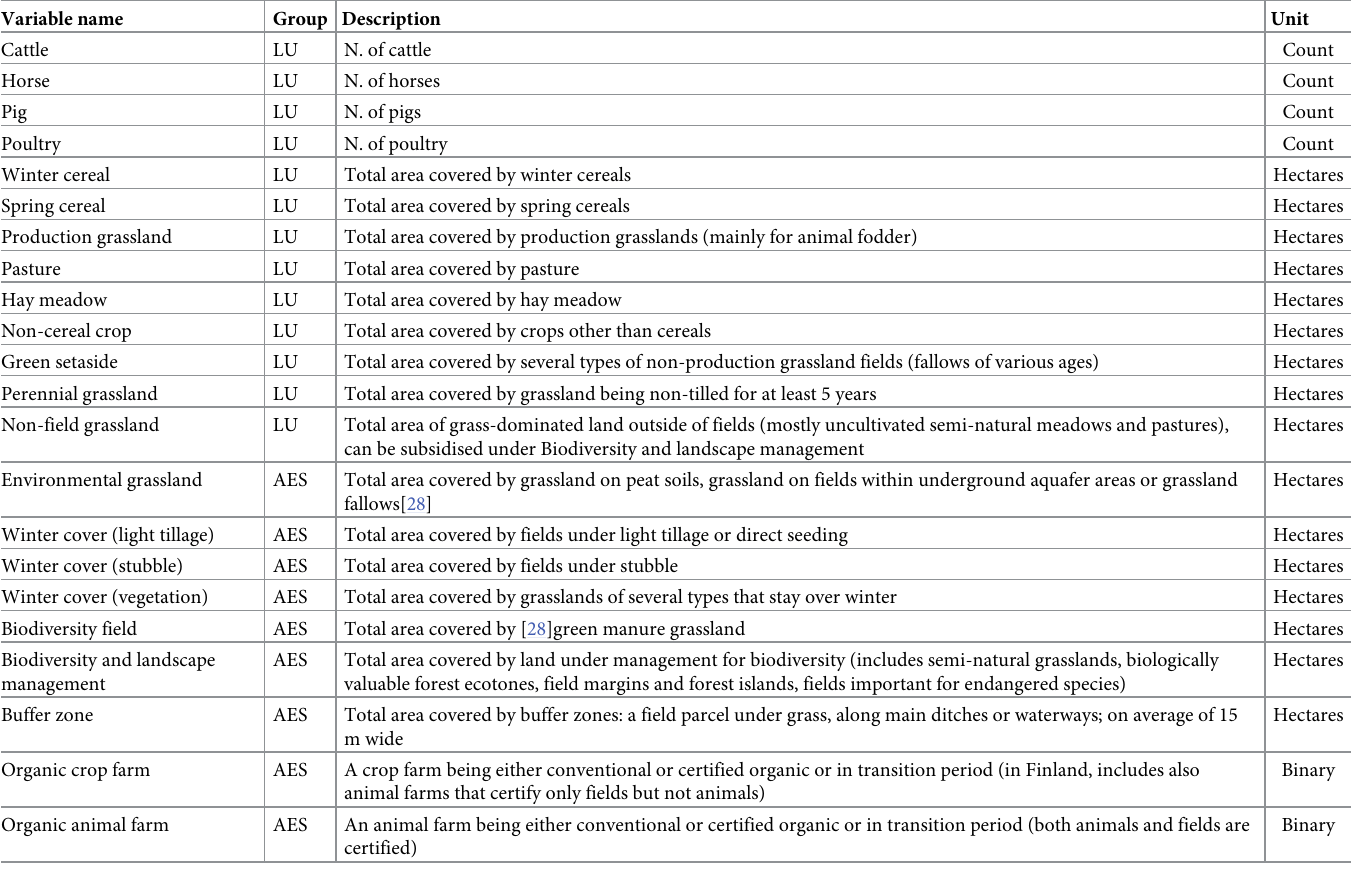
Table 1. List of the 22 variables depicting the land-uses (LU) and agri-environment scheme (AES) measures on farm considered for this study along with their description and original unit of